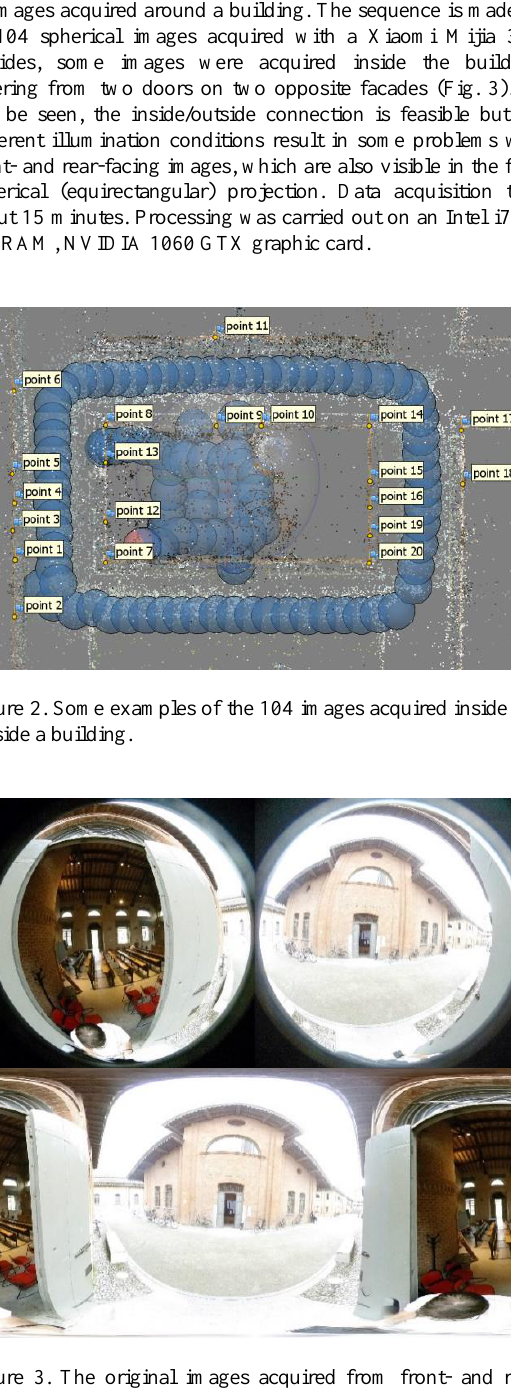
Figure 3. The original images acquired from front- and rear- facing cameras (top) and the final spherical image generated by stitching the previous images